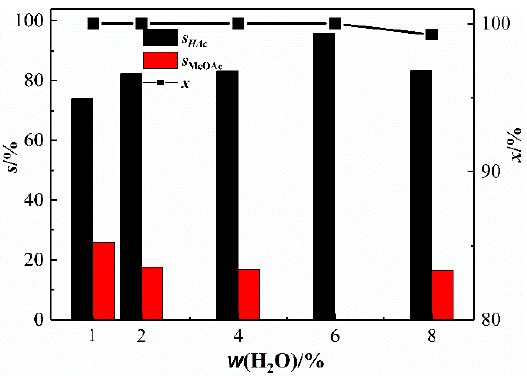
Figure 8. Catalytic performance of Rh(I)/Ru(III) bimetallic catalysts at different contents of water (T = 190 °C; p = 3.5 MPa; t = 60 min; w(CH 3 COOH) = 54 wt%; x /%: conversion rate of methanol).